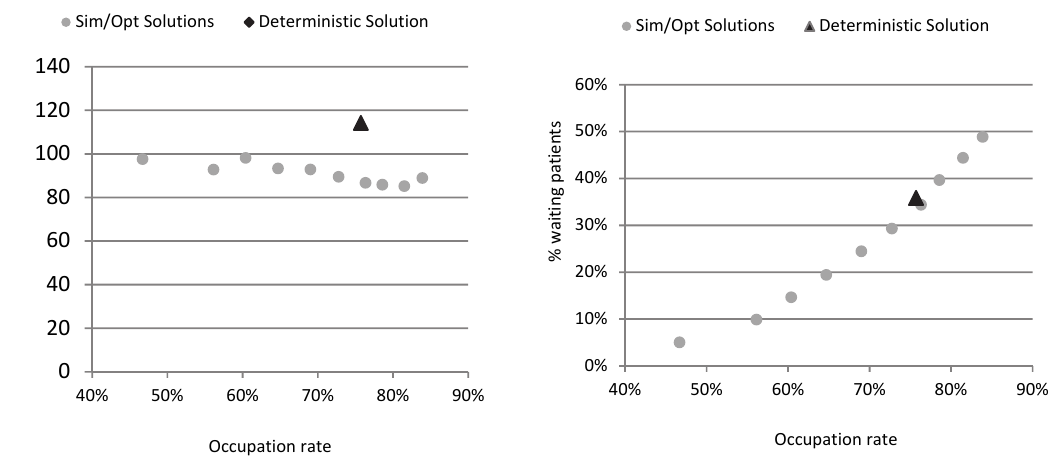
Fig. 3. Pareto frontier between waiting time, percentage of waiting patients and occupation rate